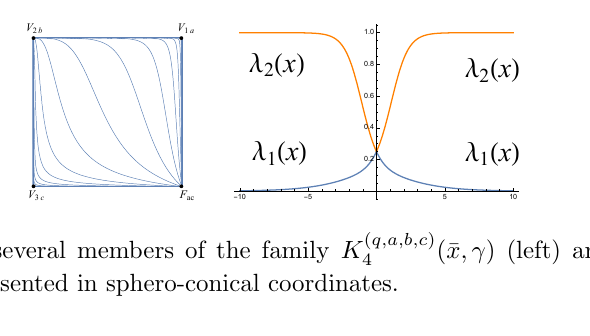
((cid:22) x; (cid:13) ) (left) and (cid:12)eld components 4